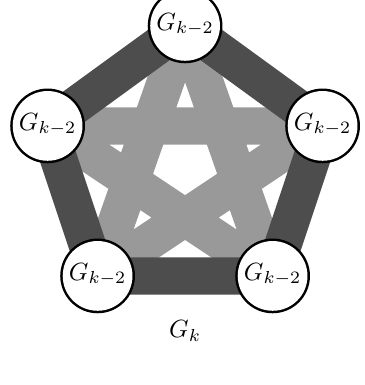
Figure 1: An example of this